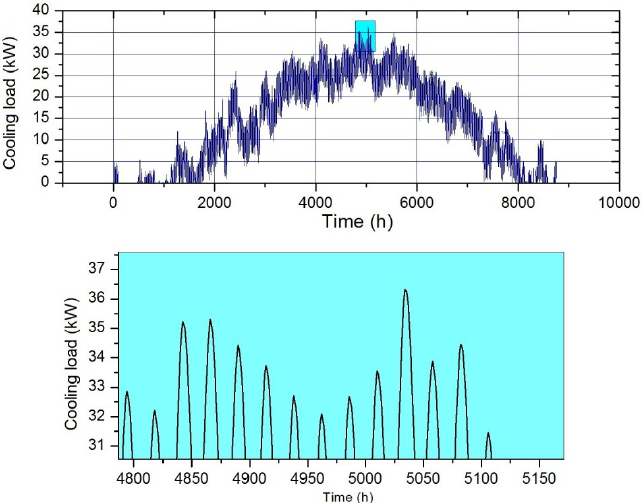
Figure 9. Annual cooling load in a duplex house.